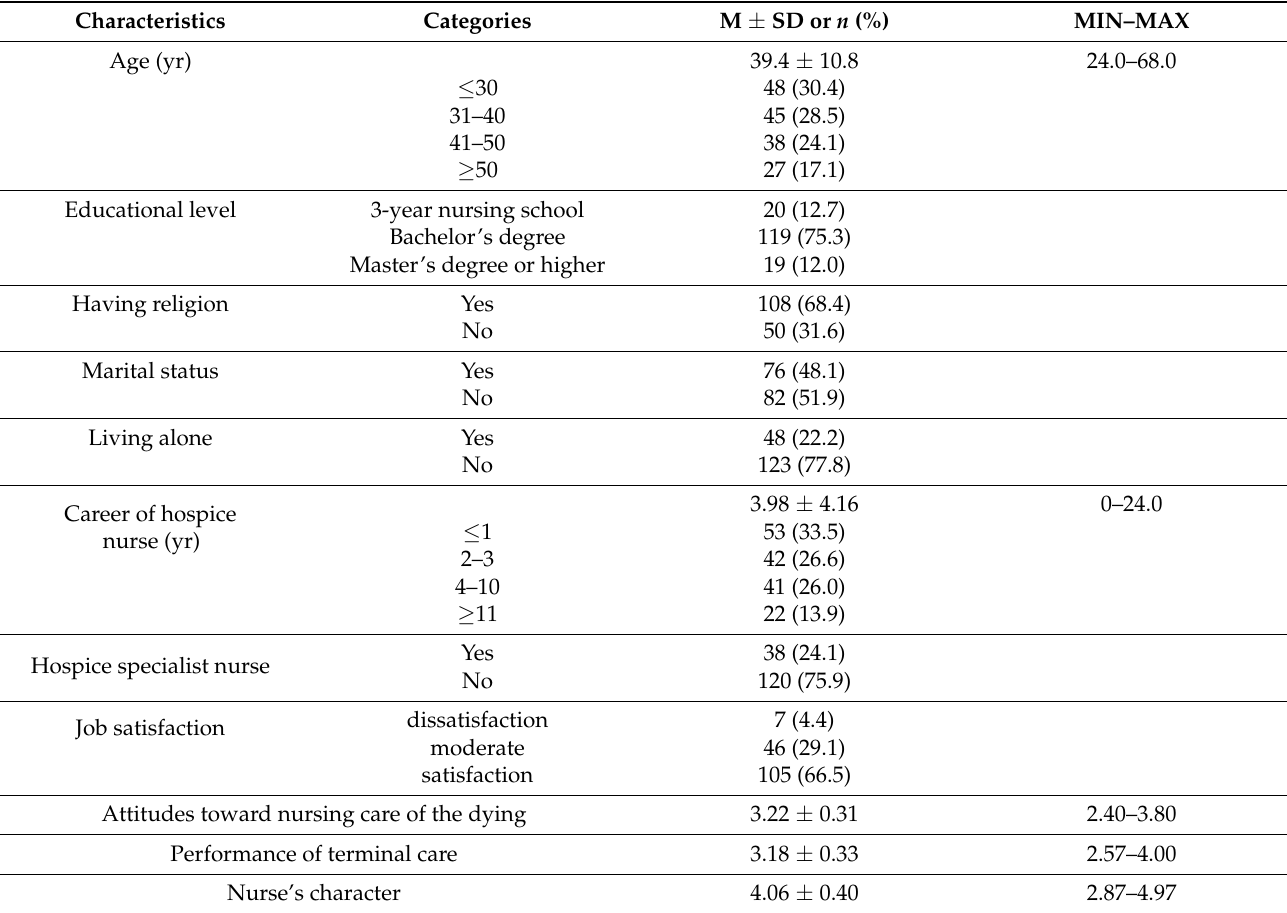
Table 1. General characteristics of participants ( n = 158).